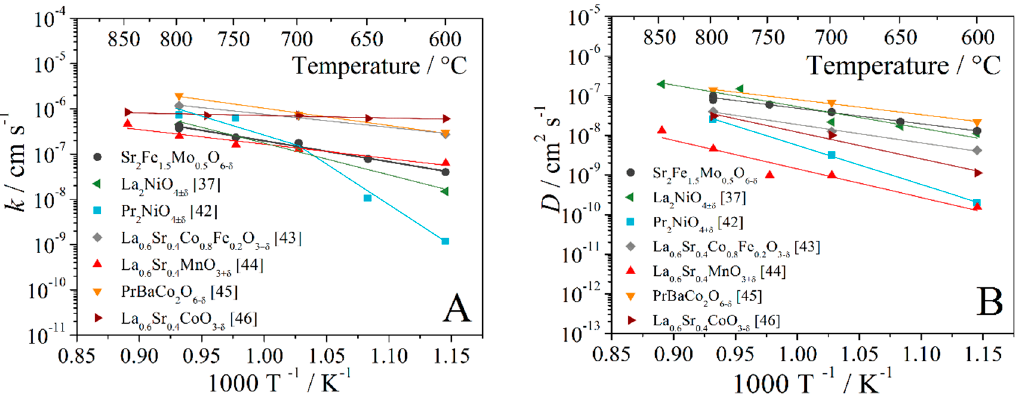
Figure 6. Temperature dependences of the oxygen surface exchange coefficient ( A ) and the oxygen diffusion coefficient ( B ) for oxides [37,42–46].